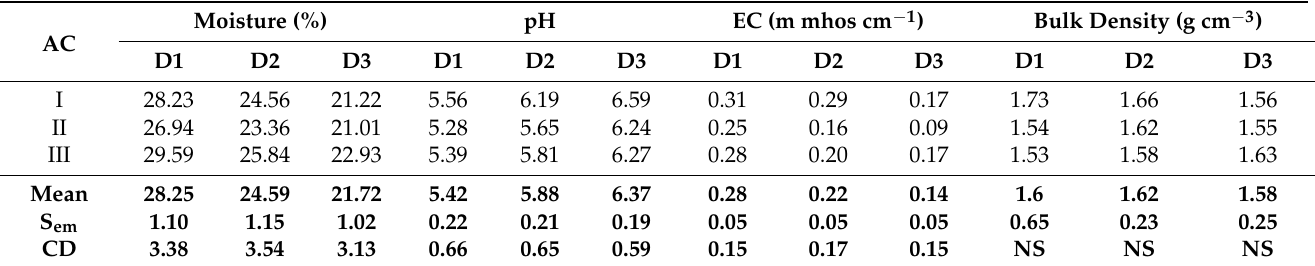
Table 2. Soil moisture, pH, electrical conductivity (EC) and bulk density in Gmelina plantations.